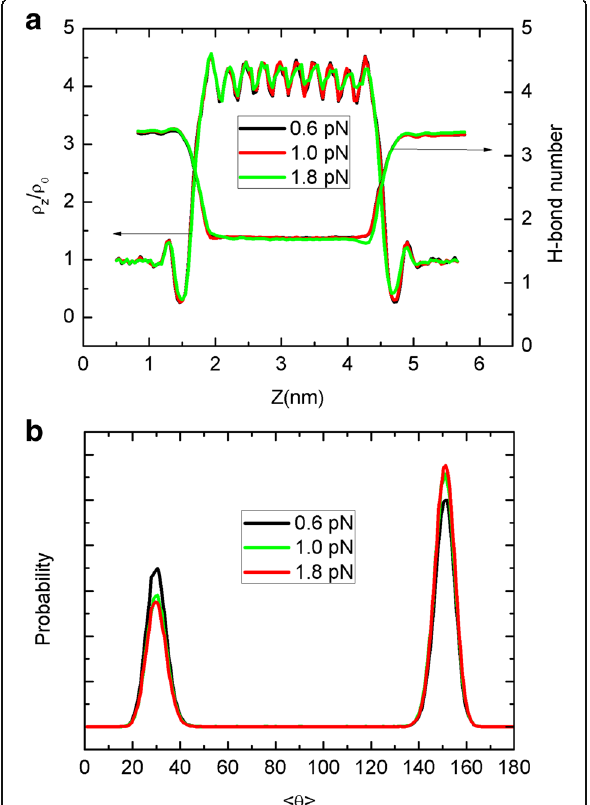
Fig. 8 a The axial water density profiles and hydrogen bond number as a function of z position along the CNT for different force. b Probability distribution of the average dipole orientation of water molecules inside the CNT for different